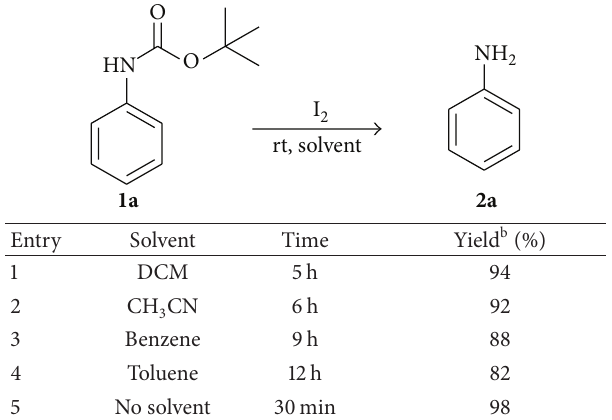
Table 1: Effect of solvents on iodine-mediated de- N - tert -butoxy- carbonylation of N -Boc-aniline ( 1a ) a .